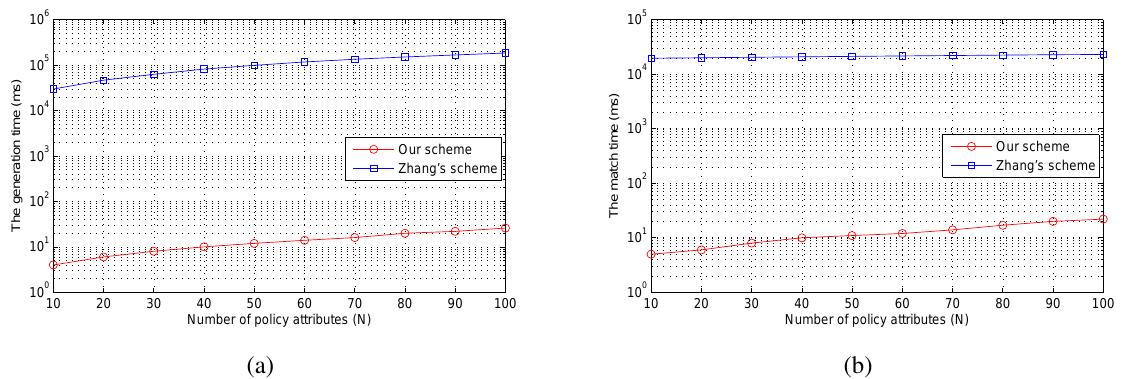
Figure 6. The performanceof match schemes. ( a ) the generation time for matching; ( b ) the match